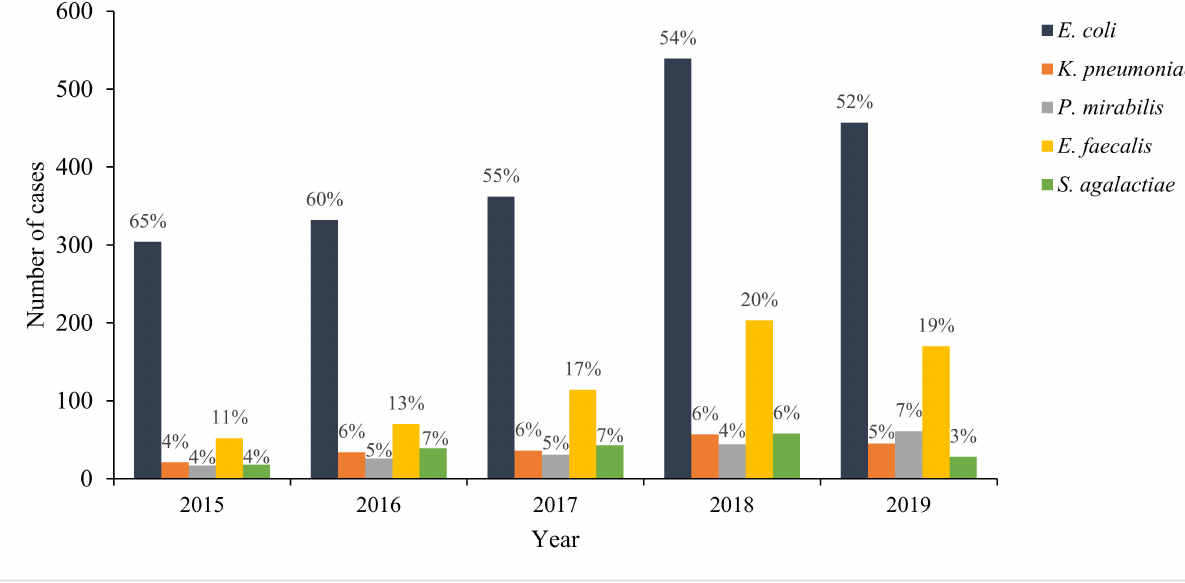
Figure 2. Annual distribution of predominant uropathogens among cases of culture-confirmed urinary tract infection in an- tenatal clinics at four tertiary public-sector hospitals in Gauteng Province, 2015–2019. Number of cases were: n = 471 (2015); n = 554 (2016); n = 655 (2017); n = 996 (2018); n = 882